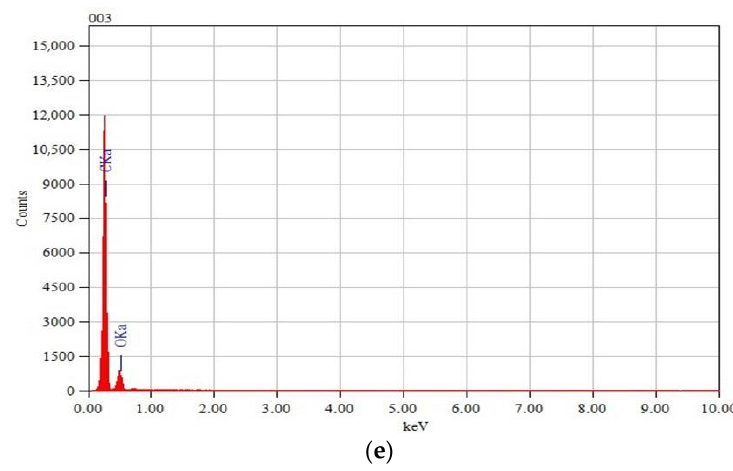
Figure 4. Polypropylene fibers used in the research: ( a ) macrophotograph of the fibers, ( b ) microphotograph of the fibers (using scanning electron microscopy (SEM) and the backscattered electron (BSE) detector), ( c ) surface topography of the fibers (using SEM and the BSE detector), ( d ) histogram of the fibers’ diameters, ( e ) X-ray diffraction spectrum obtained from the area presented in Figure 4c.